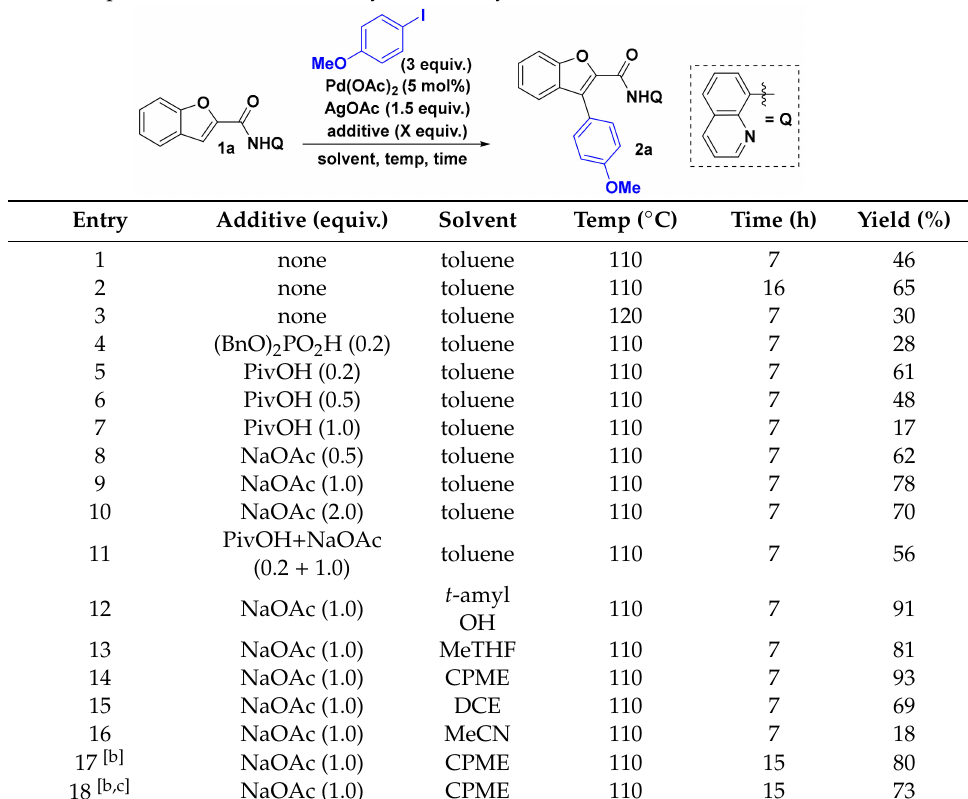
Table 1. Optimization of the Pd-catalyzed C–H arylation of substrate 1a with 4-iodoanisole [a]